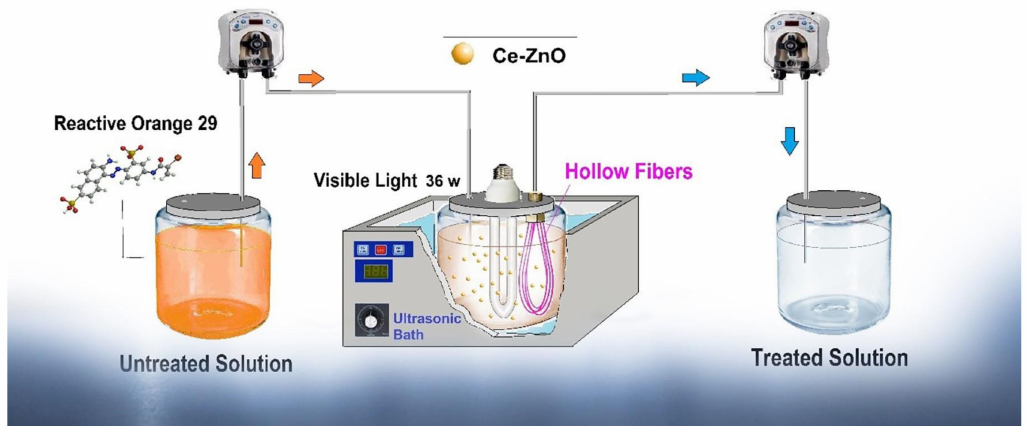
Figure 12. Schematic of SPMS reactor used by Sheydaei et al. Reprinted with permission from ref. [149]. Copyright © 2021 Elsevier